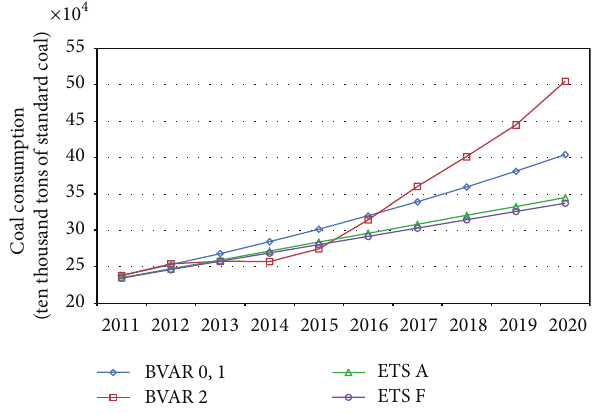
Figure 6: Total coal consumption